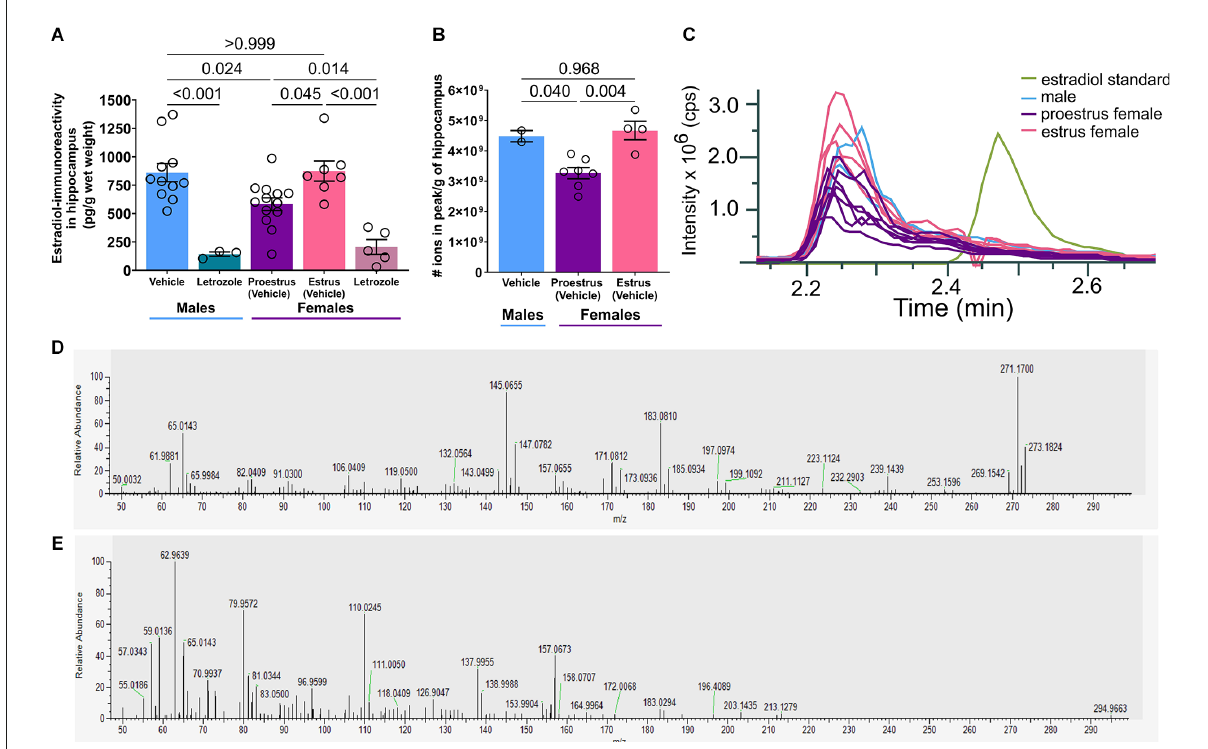
FIGURE3 Systemic aromatase inhibition decreases hippocampal, ELISA-measured estradiol-immunoreactivity but estradiol was not detected by mass spectrometry. (A) Estradiol-immunoreactivity in the hippocampus (pg/g of hippocampus wet weight) as measured by estradiol ELISA. Letrozole reduces hippocampal estrogen. Estradiol in proestrus female hippocampus is lower than estradiol in male or estrous female hippocampus ( n = 3–13/group). (B) The number of ions in the measured peaks (m/z 271.17) normalized to g of the hippocampus. Again, concentration in proestrus female hippocampus is lower than in male or estrous female hippocampus ( n = 2–7/group). (C) The m/z 271.17 peak in hippocampus samples elute at 2.24 min while a 17 β -Estradiol standard elutes at 2.47 min, indicating that these peaks are not 17 β -Estradiol. (D) MS/MS spectrum of the [M-H]- ion (m/z 271.1704) for a 1:1 mixture of deuterated-labeled and unlabeled estradiol standards. (E) MS/MS spectrum of the [M-H]- ion (m/z 271.1704) for an unknown compound identified in a male hippocampus. Post test p-values are provided above the corresponding comparisons. Individual points represent individual mice. Data are presented as mean ±